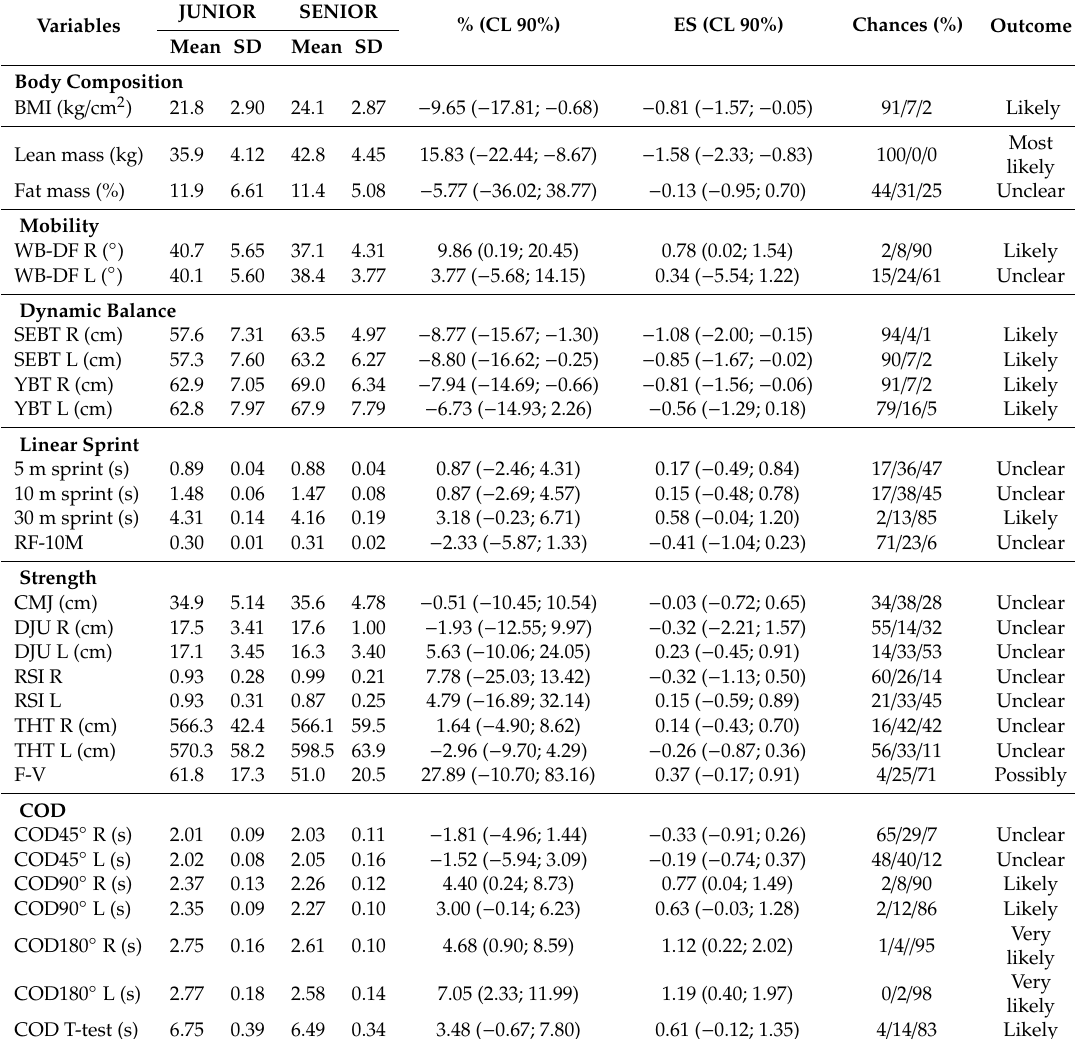
Table 1. Data description referred to body composition, mobility, dynamic balance, linear sprint, strength, and change of direction according to player